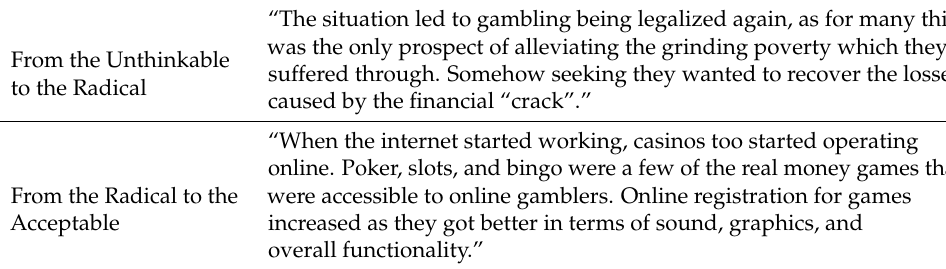
Table 1. Overton window phases and verbatim